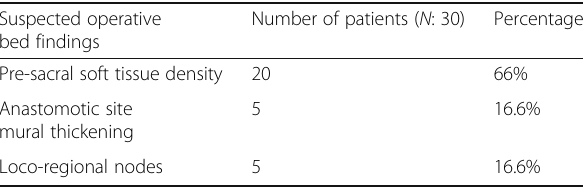
Table 2 Distribution of the studied patients according to